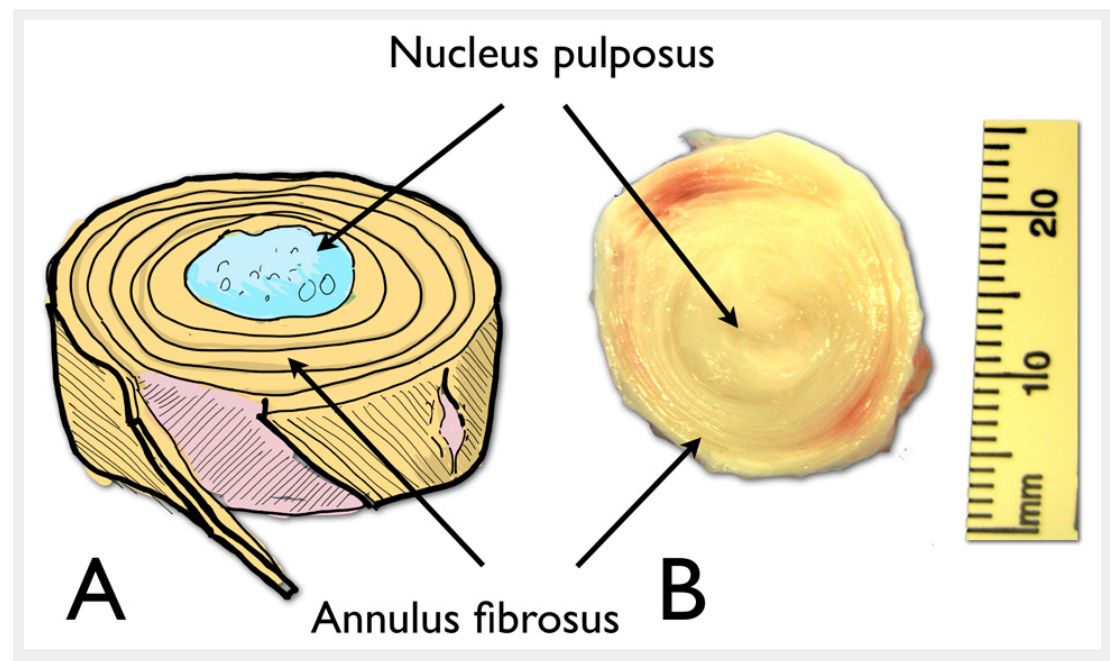
A. Overview of the IVD. Schematic view of nucleus pulposus and annulus fibrosus. B. Transverse view onto fresh-cut caudal bovine intervertebral disc (animal aged ~1 year). The two tissue types can be clearly distinguished